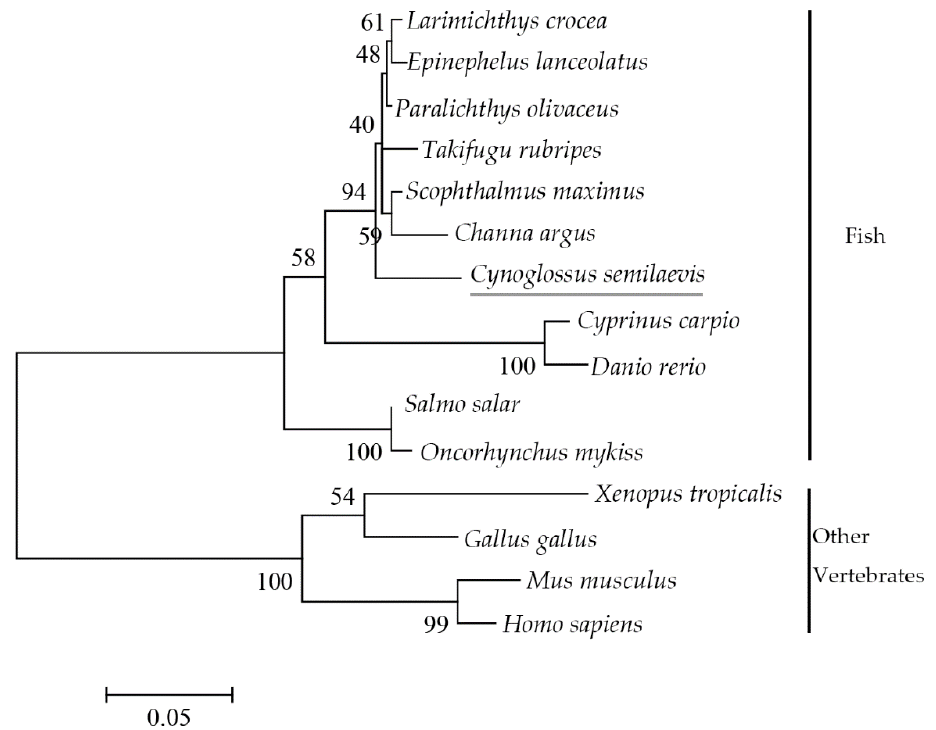
Figure 3. Phylogenetic tree of Cyp26b1 in Chinese tongue sole and other species based on the ML method. Bootstrap values were based on 1000 resampling replicates.